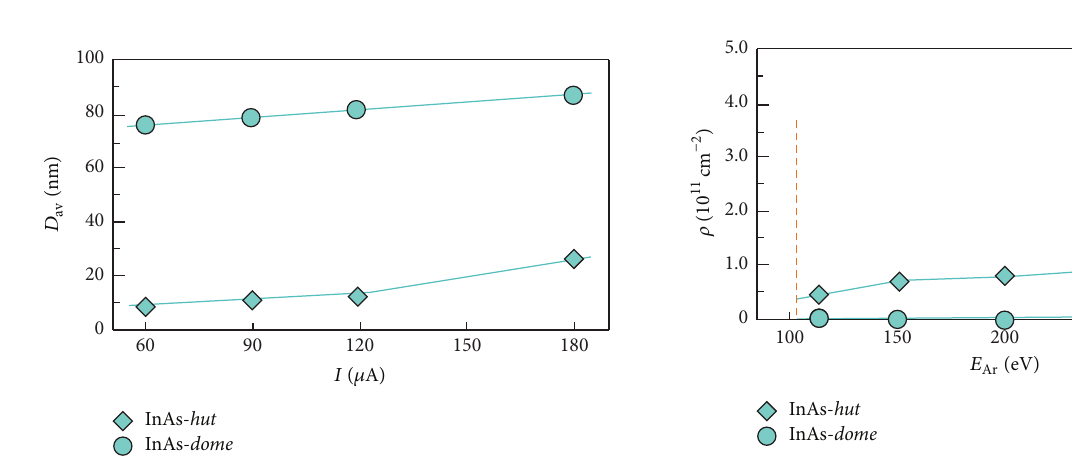
Figure 11: Surface density of InAs nanoislands as a function of ion